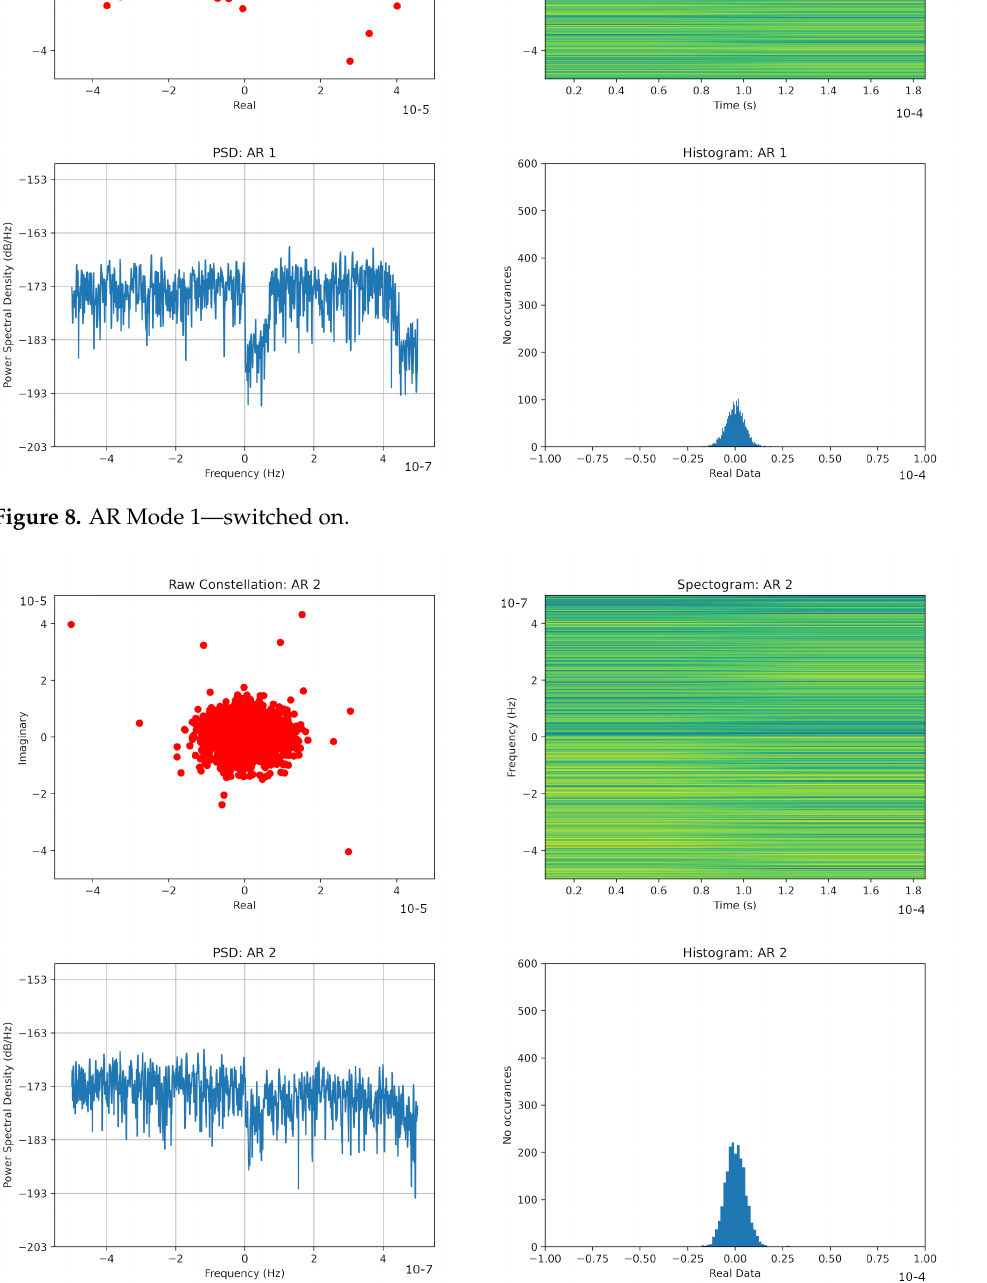
Figure 9. AR Mode